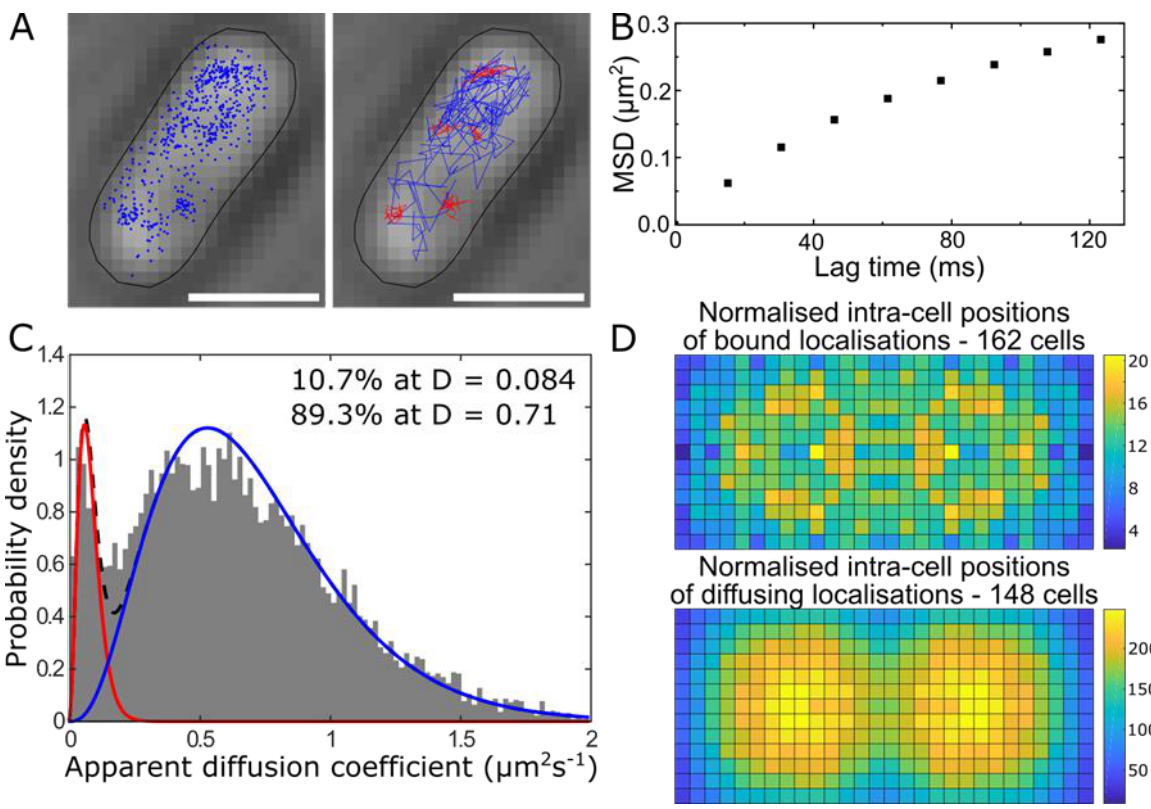
FIGURE 7: PALM imaging. Tracking PALM experiment with DNA polymerase I-PAmCherry fusions in E. coli , performed 30 min following treatment with 100 mM MMS. (A) Bright-field image of a single E. coli cell superimposed with the detected cell boundary mesh, molecular localizations (left), and compiled molecular tracks (right). Scale bars, 1 µm. (B) Mean MSD analysis obtained for 2,048 molecular tracks. (C) Apparent diffusion coefficient histogram from 2,048 molecules, calculated from MSDs; the inset numbers indicate the proportion of molecules in each population. (D) Heat maps of molecular localizations for the bound (top), and freely-diffusing (bottom)